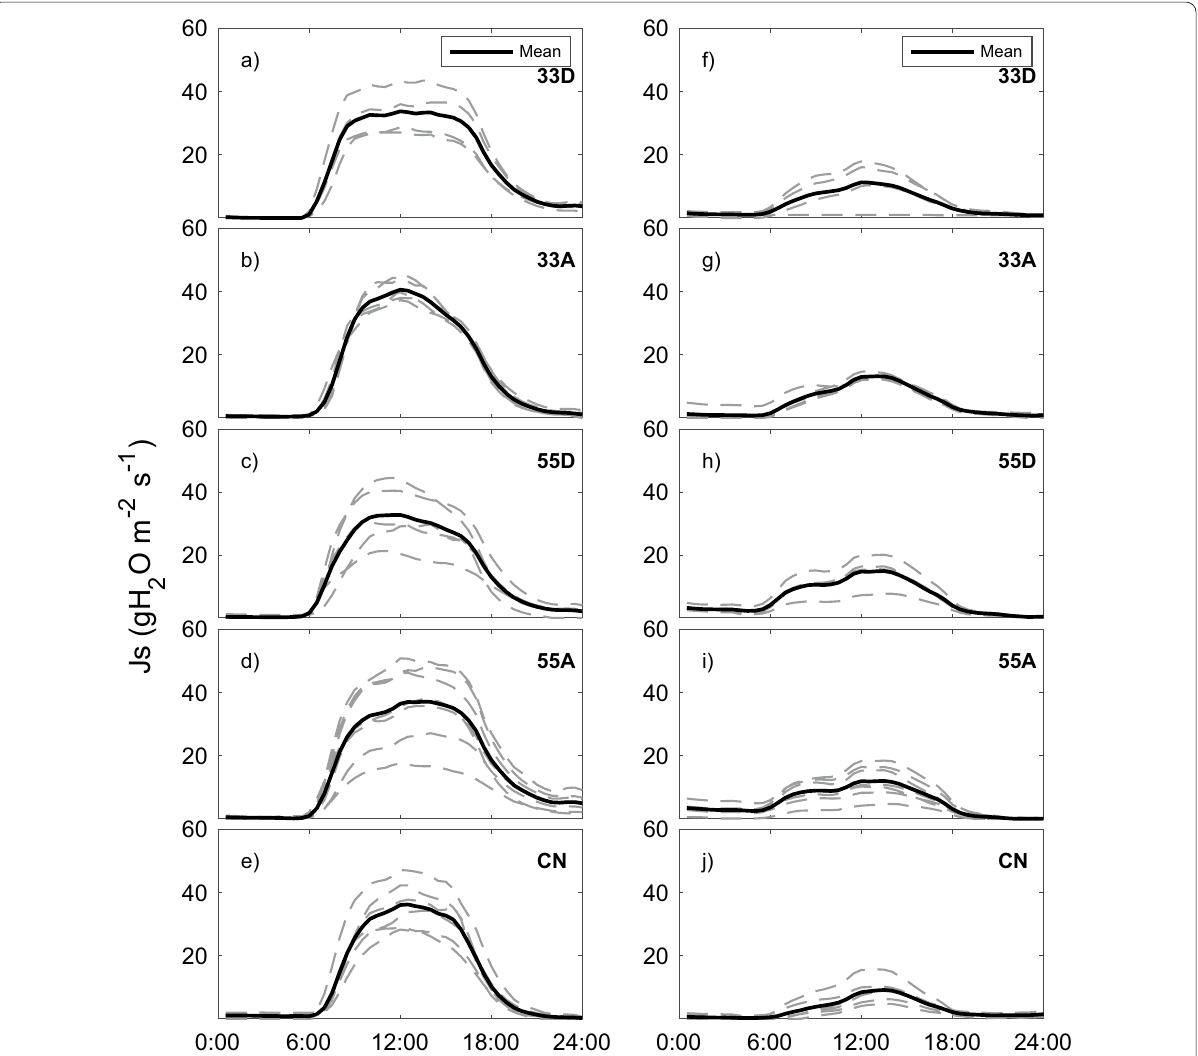
Fig. 5 Sap flux density for a 24 h period on a warm, sunny day (5 September 2018; a – e ) and on a cool, cloudy day (12 October 2018; f – j ). Data from individual sensors (6–8 sensors per plot) is shown in the dashed lines and the mean is shown in solid